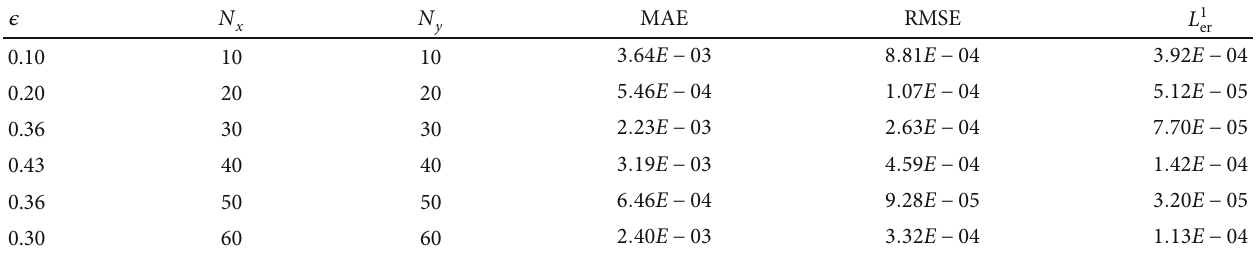
, N , and ϵ using IMQ. x y